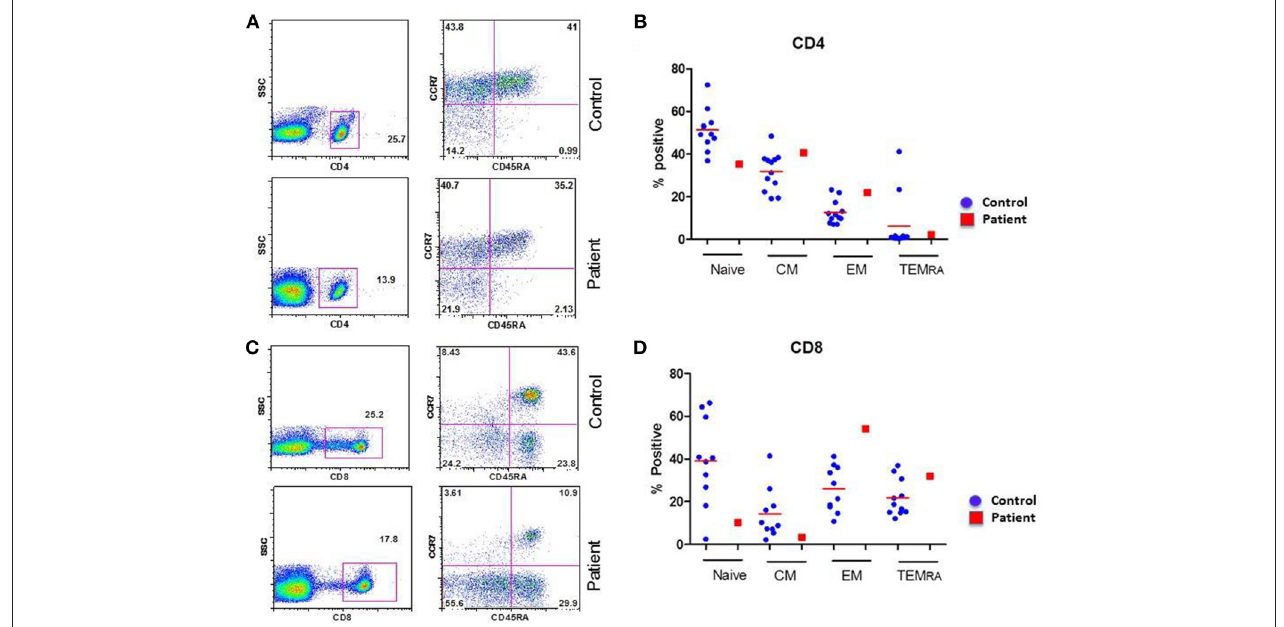
FIGURE 1 | Subsets of CD4 + (A,B) and CD8 + (C,D) T cells. (A,C) are flow cytograph from the patient and a simultaneously analyzed healthy control. (B,D) show individual data from 10 healthy controls and the patient. CD8 T EM cells are increased, and CD8 T N and CD8 T CM cells are decreased in the